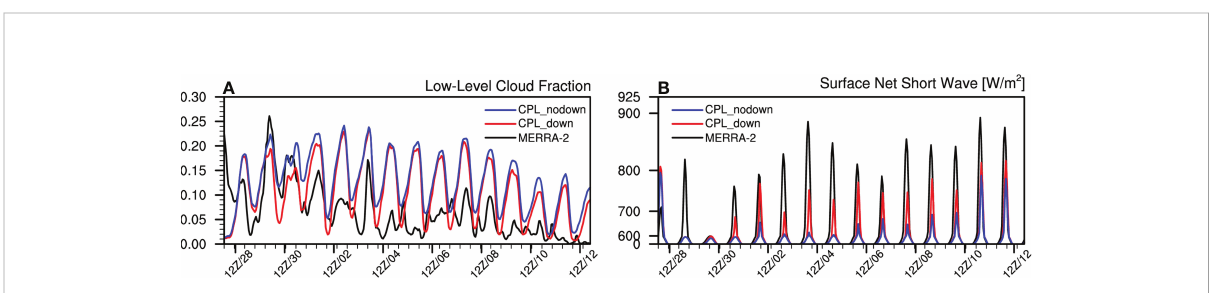
FIGURE 10 Area mean values of low-level cloud fractions (LCFs) (A) and the surface net short wave time series (B) for the MERRA-2 data (black) and the CPL_down (red) and CPL_nodown (blue) simulations every 3 h for the 1994 case.